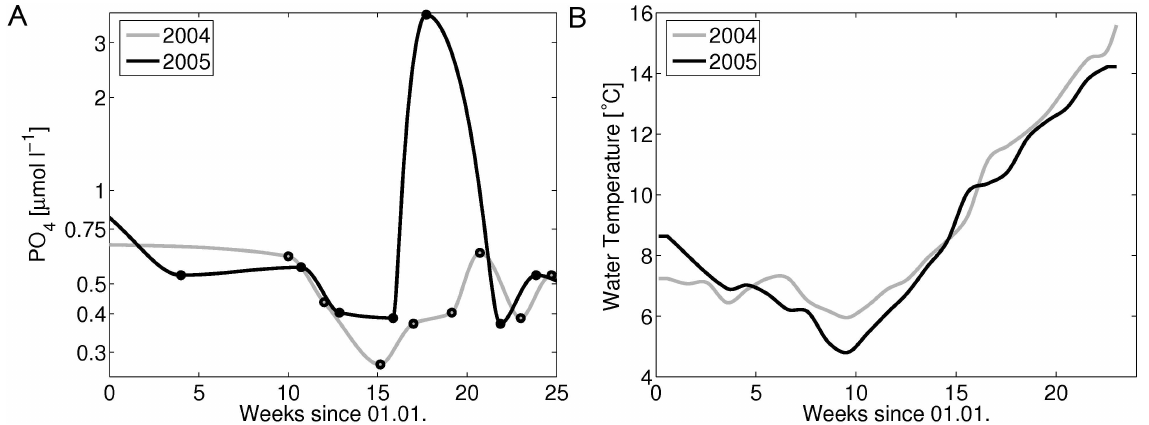
Fig. 2. (A) Phosphate in filtered surface water as the mean of measurements in the western German Bight (5 . 10 ◦ E, 53 . 46 ◦ N and 5 . 15 ◦ E, 53 . 41 ◦ E, fig. 1) in 2004 (grey line) and 2005 (black line) (source: DONAR database operated by the Dutch Ministry of Transport, Public Works and Water Management). (B) Weekly mean sea surface temperature, averaged between 5 and 8 ◦ E measured by the FerryBox in 2004 (grey line) and 2005 (black line).